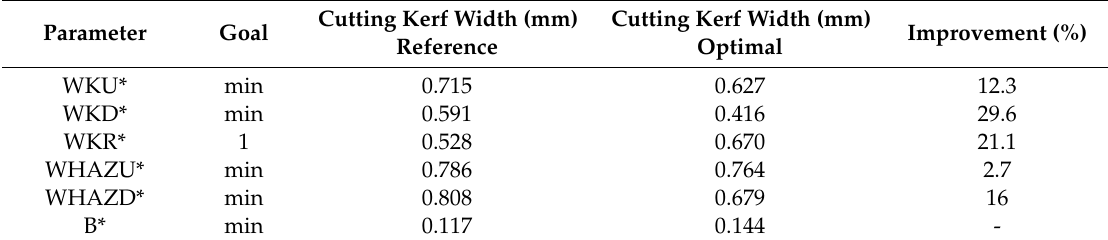
Table 6. A table presenting the parameters at 150 W power (reference) and 100 W power (optimal), for a cutting speed of 9 mm · s − 1 and AR = 3.